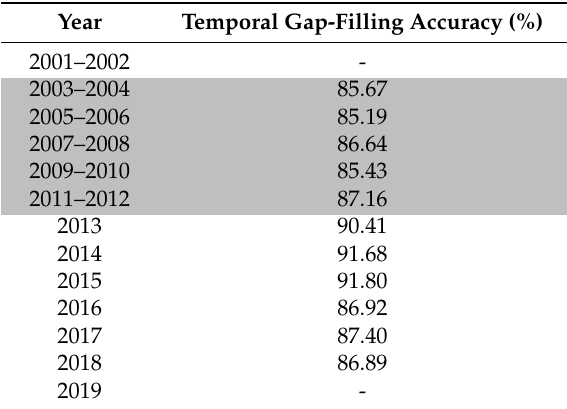
Table 4. Validation results of land use classification for Landsat-7 and Landsat-8. Years with SLC malfunction are shaded in grey considering the higher